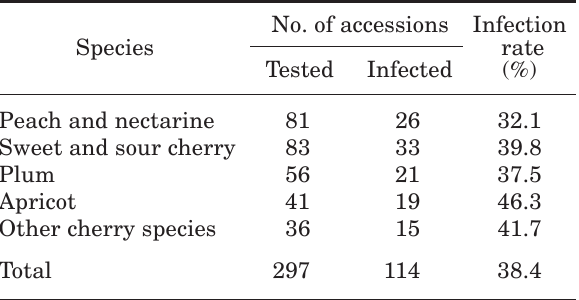
Table 3. Sanitary status of Clonal Genebank Prunus accessions (Harrow, Canada) as determined by ELISA and molecular hybridization No. of accessions Infection Species rate